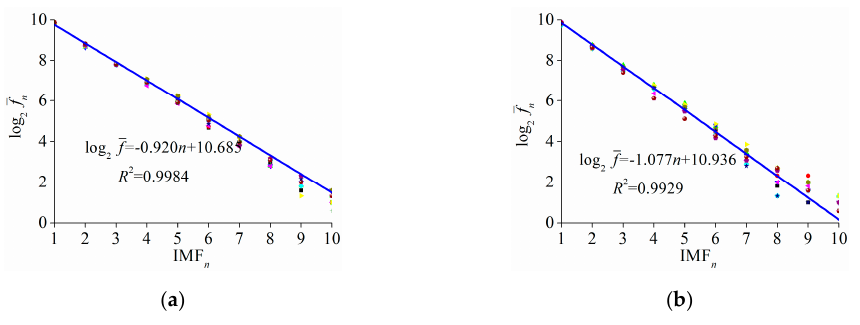
Figure 7. Average frequency ( f ) of each IMF n . ( a ) Signal without an obvious change and ( b ) signal with an obvious change.